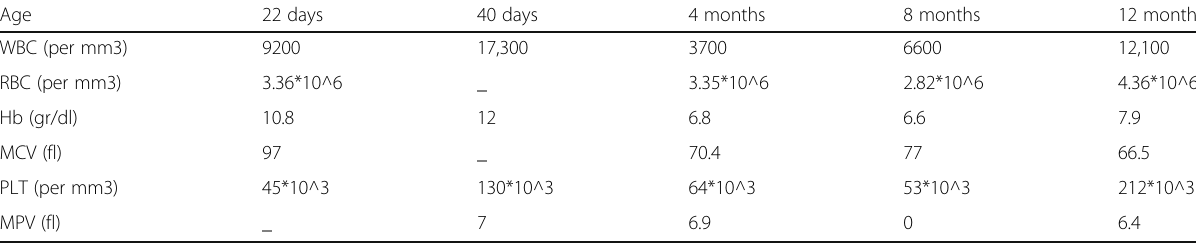
Table 1 Results of complete blood count at different ages of the proband Age 22 days 40 days WBC (per mm3)